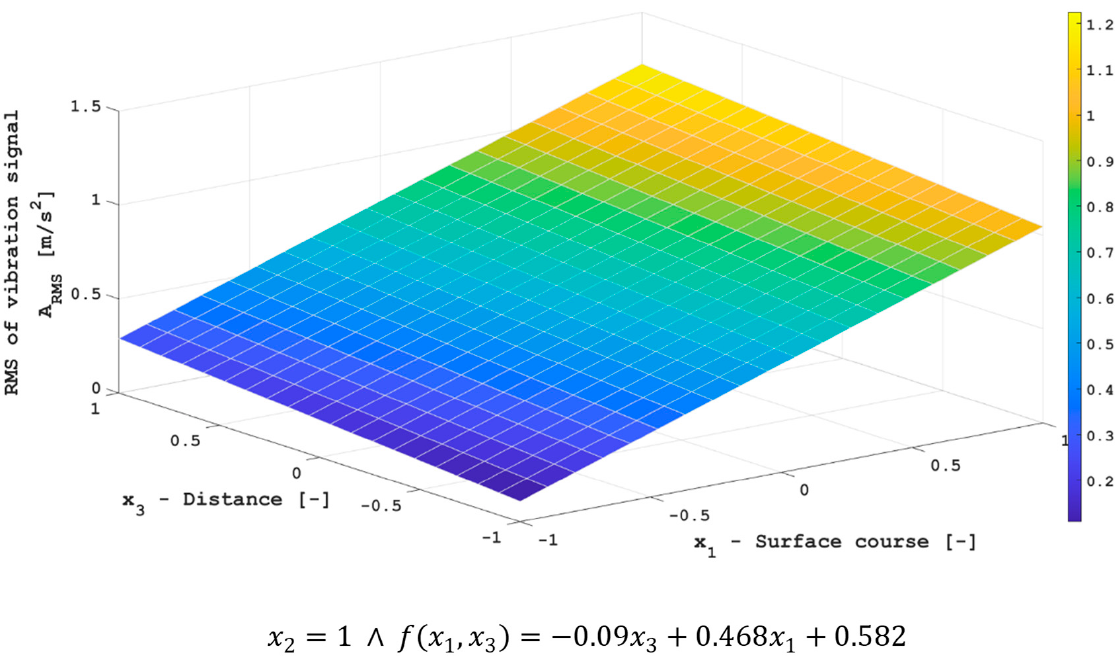
Figure 8. A RMS signal values depending on the surface course and the distance traveled, when moving an electric scooter at a speed of 20 km/h.